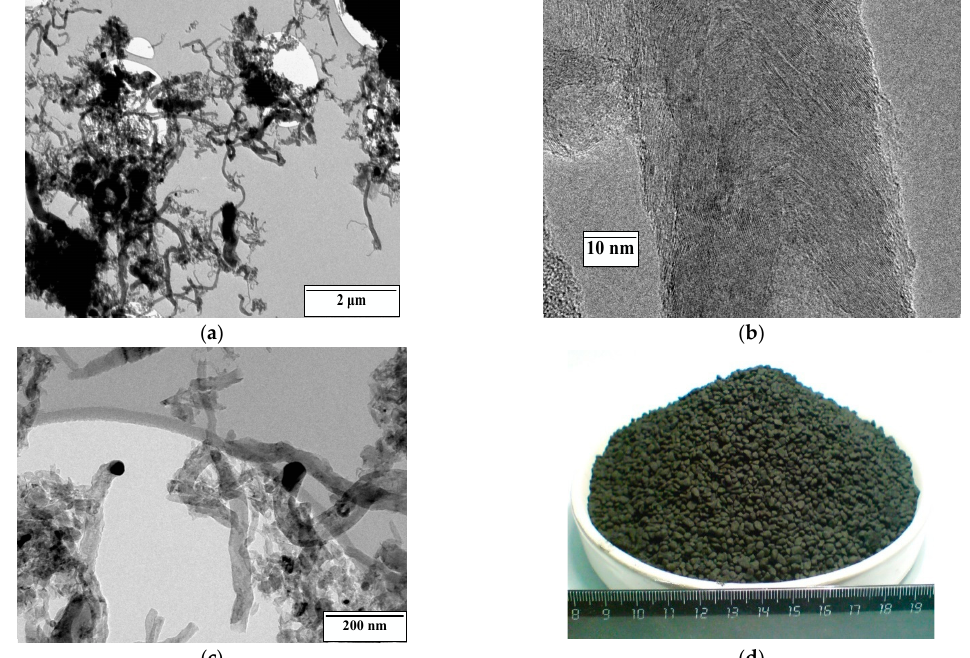
Figure 2. TEM images of carbon nanofibers used as an active material for gas sensors ( a – c ) and the photo of as-received granules of CNF material ( d ).